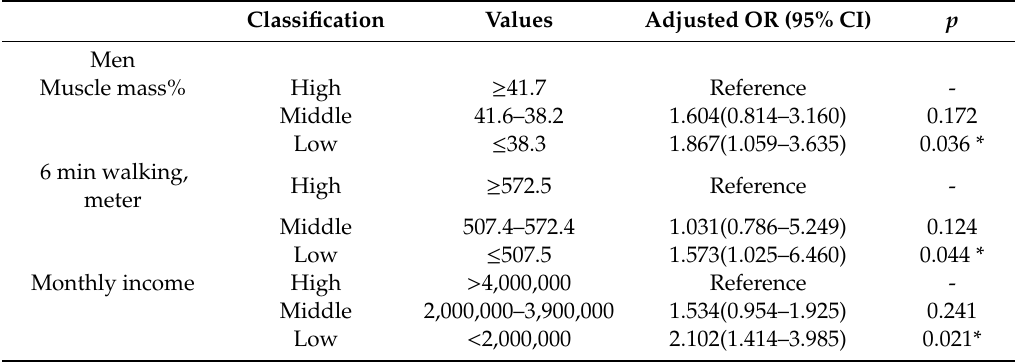
Table 4. Adjusted odds ratios of cardiac rehabilitation